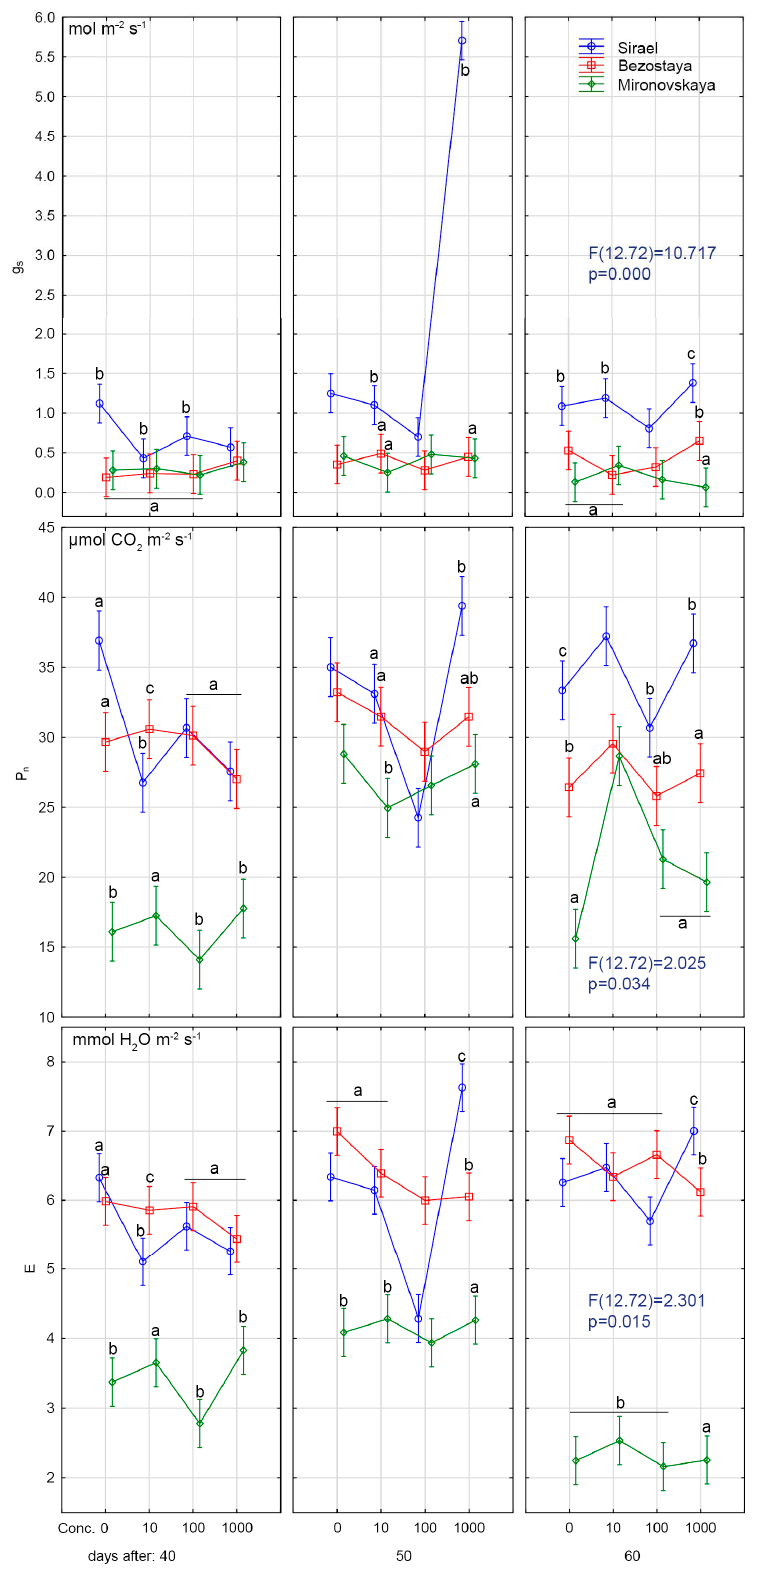
Figure 2. Effects of priming GA 3 at different concentrations on photosynthetic rate (P n ), stomatal conductance (g s ) and transpiration (E). Variety: Mironovskaya (M), Bezostaya (B) and Sirael (S). Concentrations of GA 3 : 0, 10, 100 a 1000 µL L − 1 ; measured on 40 days, 50 days and 60 days of growth. Tukey HSD test, α = 0.05. Treatments with the same sign did not differ significantly at p < 0.05.